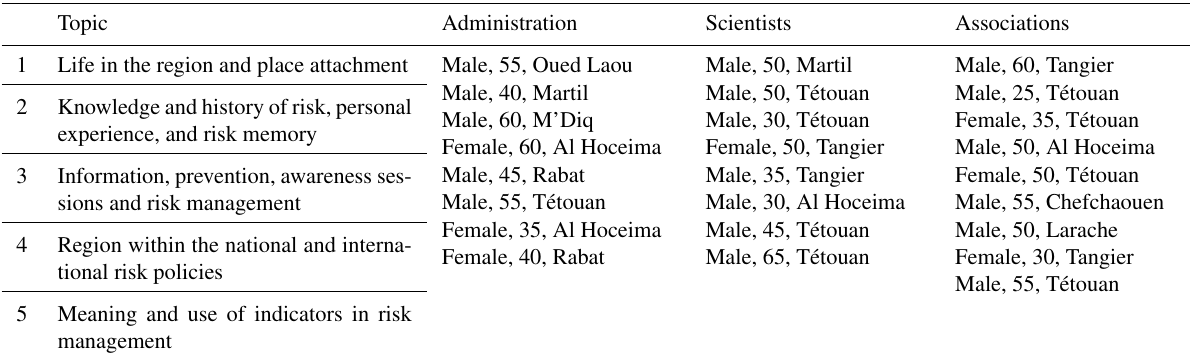
Figure 5. Schematic presentation of the binary logistic model describing willingness to invest money in disaster risk reduction, with depen- dent variable of investing money. Table 2. The main parts of the interview guide and the individual interviews with stakeholders representing different groups of actors in north